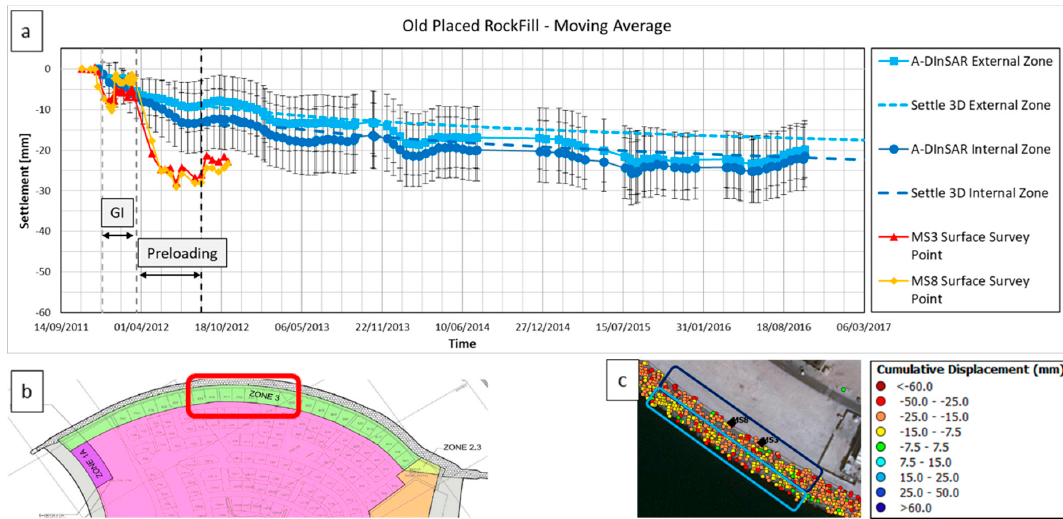
Figure 16 . ( a ) Diagram showing the data integration in old placed rockfill revetment area including the vertical component of A-DInSAR time series of displacement in dark and light blue, Settle 3D creep in dark and light blue dashed line and field monitoring data in red and yellow. Black and grey dashed vertical lines show the working phases. GI stands for ground improvement. ( b ) Location of the data showed in ( a ). ( c ) A-DInSAR derived MPs (red, orange and yellow dots) and field monitoring data (black dots). Light and dark blue boxes show the external and internal zone, respectively. The moving average of 3 to 5 samples was used to the time axis to neglect the e ff ect of short-term displacement anomalies. The sample population ranged between 50 and 200 MPs in each area. The results were averaged and an error bar equal to ± 1 σ was